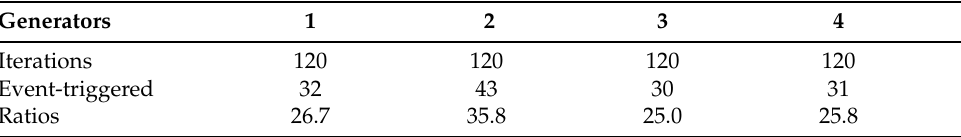
Table 2. Generator event-triggered